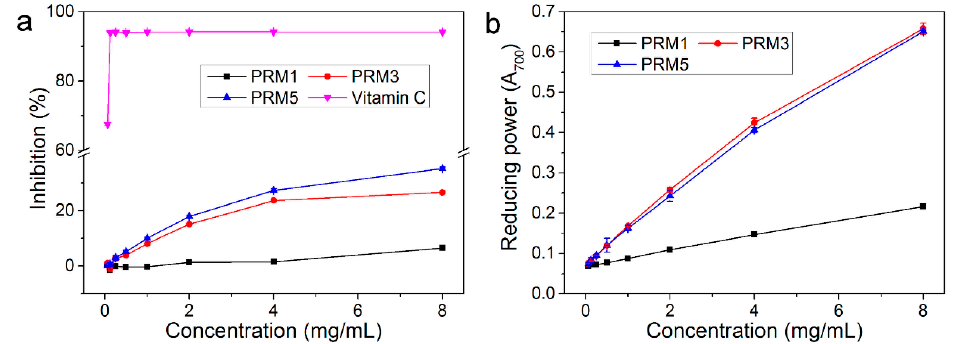
Figure 4. In vitro antioxidant activities of PRM1, PRM3 and PRM5. ( a ) DPPH radical scavenging activity; ( b ) Reducing power.